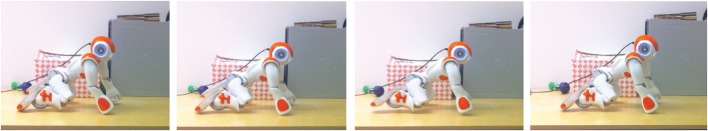
The implementation on the physical robot. This figure shows the video snapshot of one-crawling-step NAO robot on a wooden flat table (One crawling step means one time alternation of the supporting leg and arm).